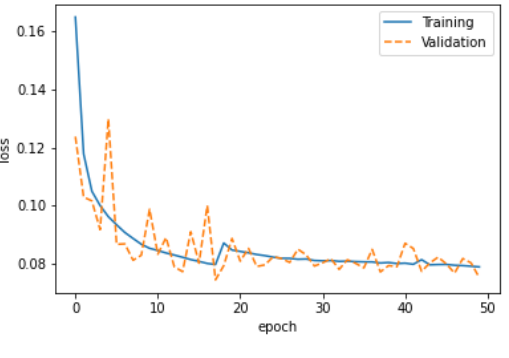
Figure 6. Best-fit